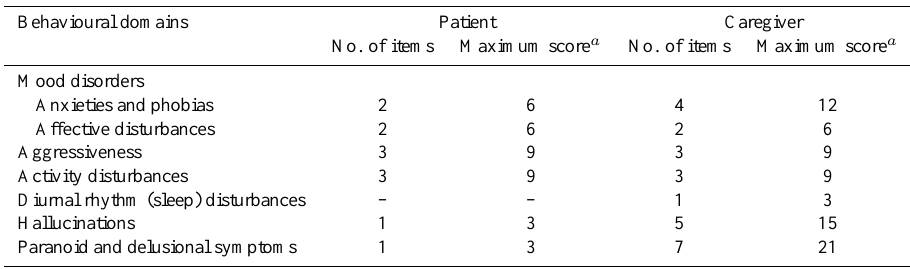
Table 1 Behavioural component of CIBIC-Plus patient and caregiver interview Behavioural domains